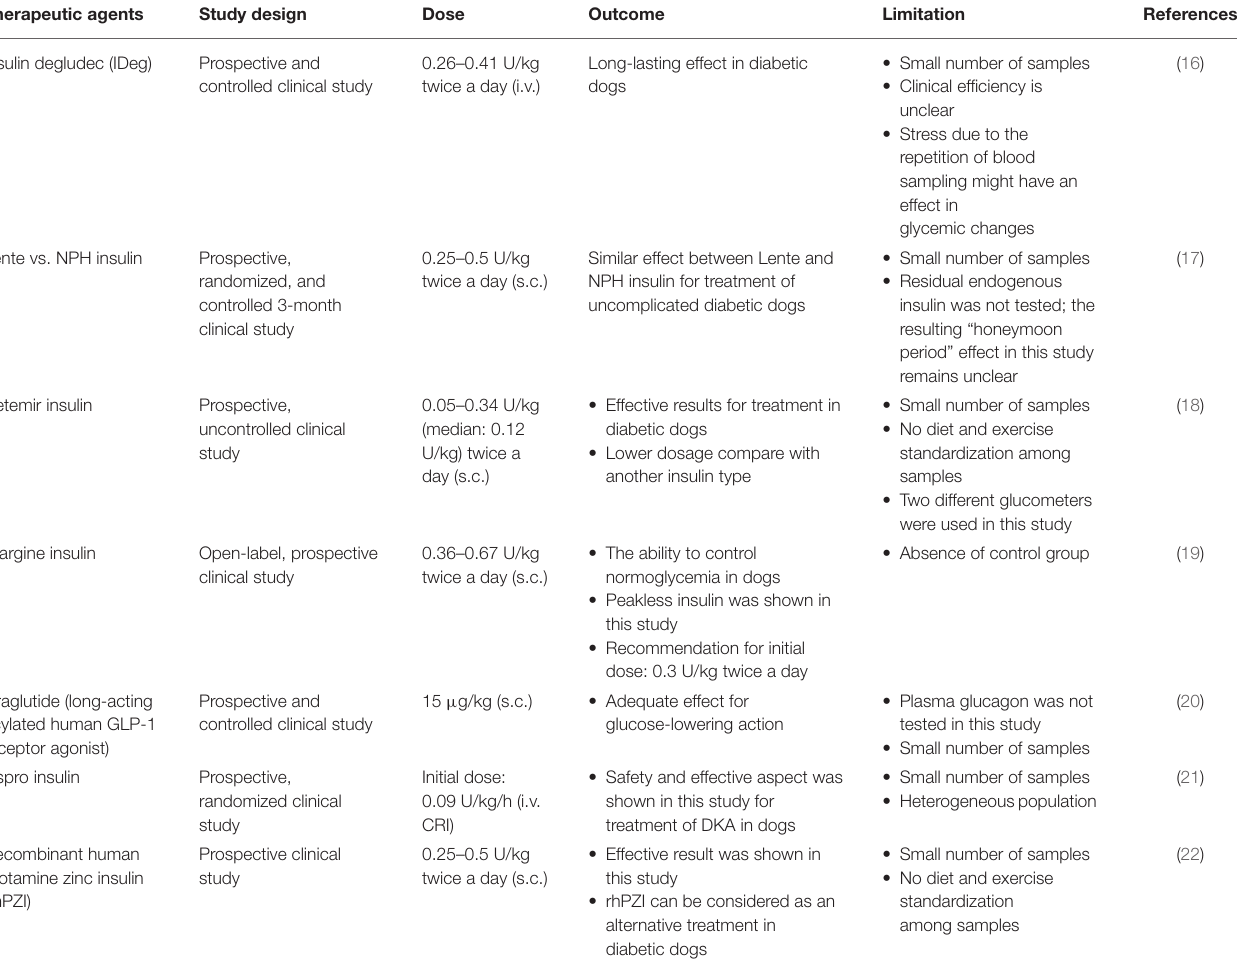
TABLE 2 | Conventional study approaches for diabetes therapy in